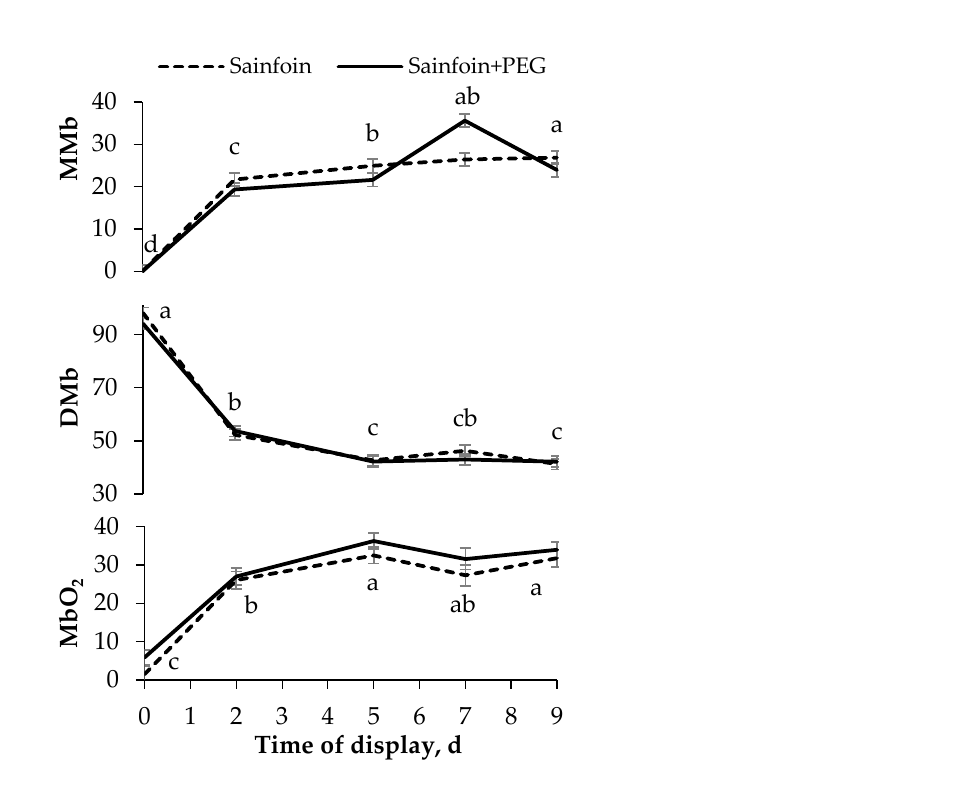
Figure 2. Evolution of heme pigments [metmyoglobin (MMb), deoxymyoglobin (DMb), and oxymyoglobin (MbO 2 )] of meat of suckling lambs according to the presence of proanthocyanidins (PAC) in their dams’ diet. Within a parameter, different letters mean differences at p < 0.05 among days. Vertical bars indicate the standard error of the